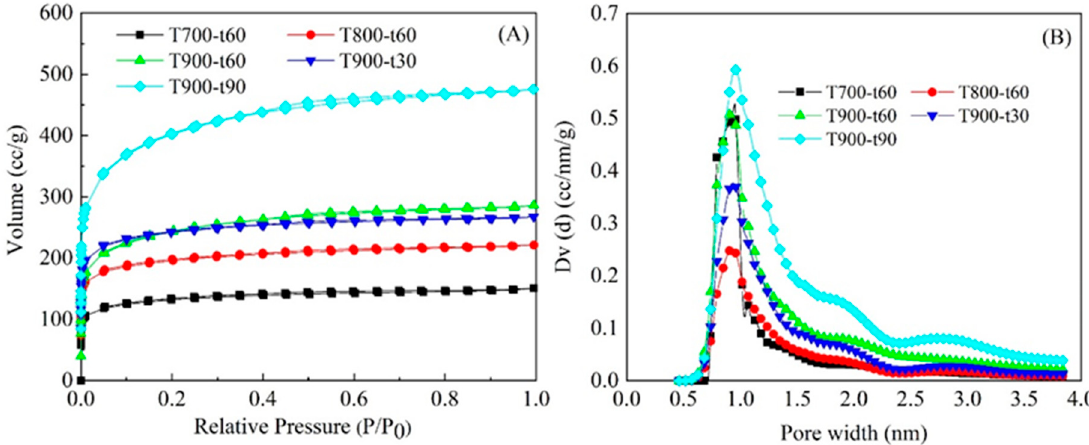
Figure 3. N 2 adsorption-desorption isotherms ( A ) and pore width ( B ) of ACFs activated with different activation temperatures and times by fixing the CO 2 gas flow rate at 300 mL/min.